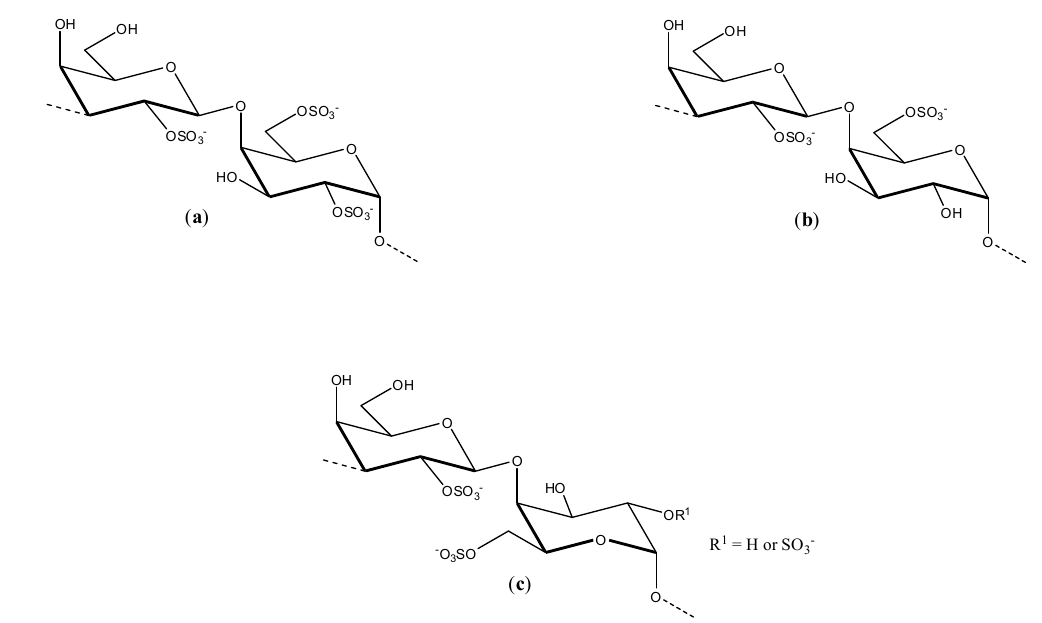
Figure 5. Disaccharides units present in the structure of C2S-3